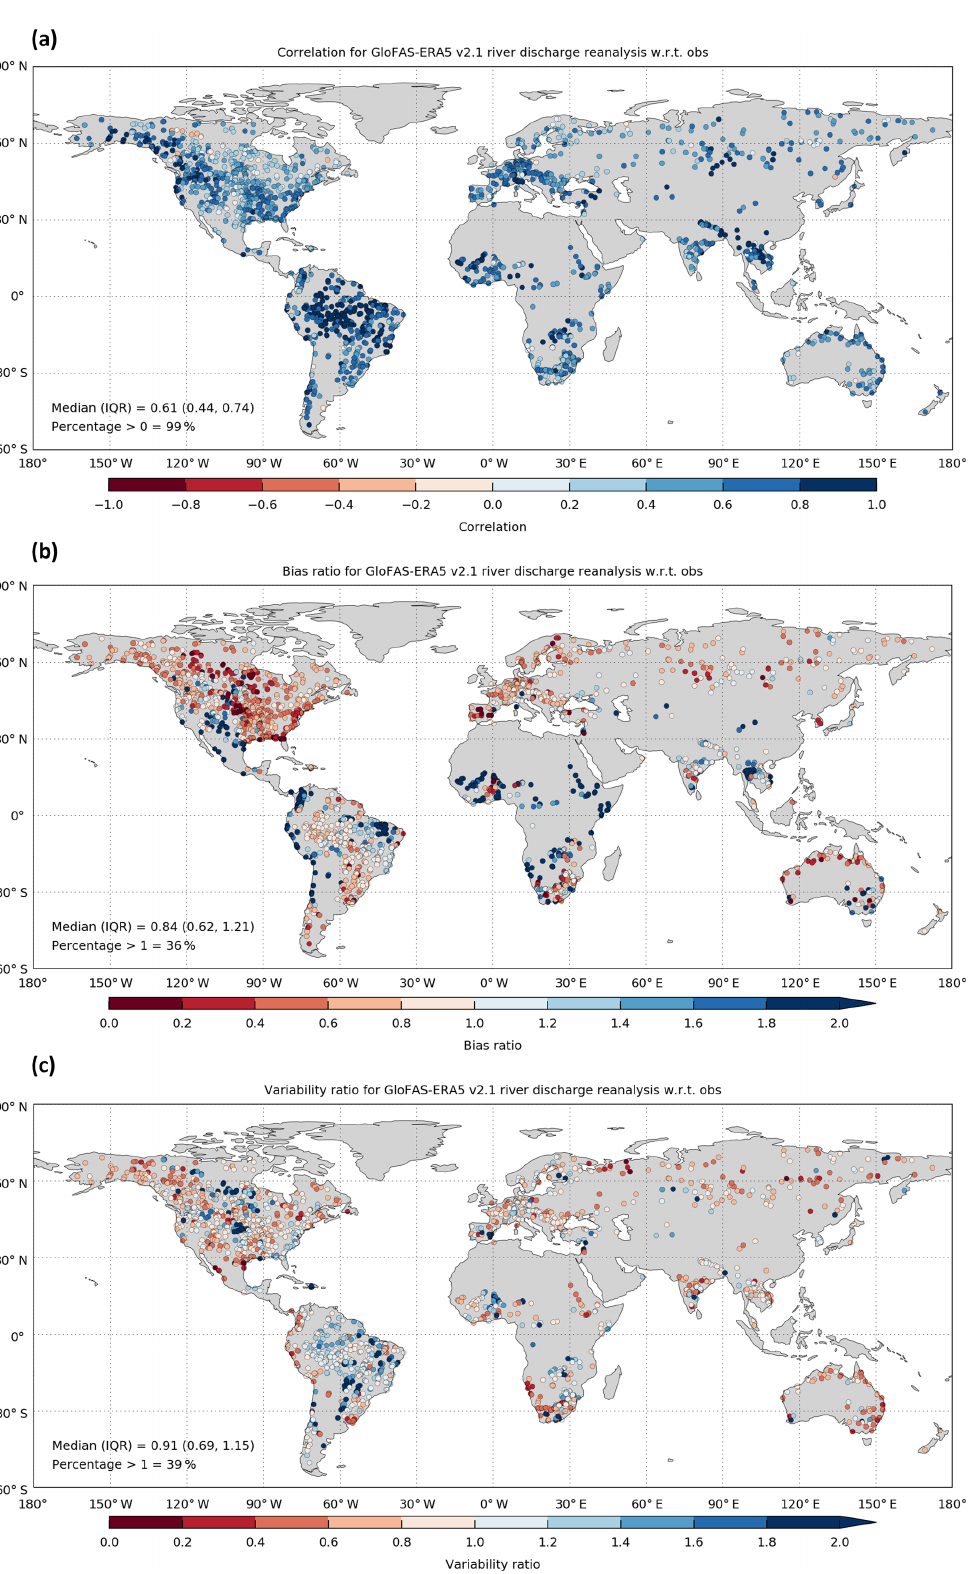
Figure 6. Decomposition of the Modified Kling–Gupta efficiency (KGE (cid:48) ) into its three components: Pearson correlation (a) , bias ratio (b) , and variability ratio (c) for GloFAS-ERA5 river discharge reanalysis against 1801 observation stations. The optimum value for each of the three KGE (cid:48) components is 1. Blue (red) dots represent positive (negative)